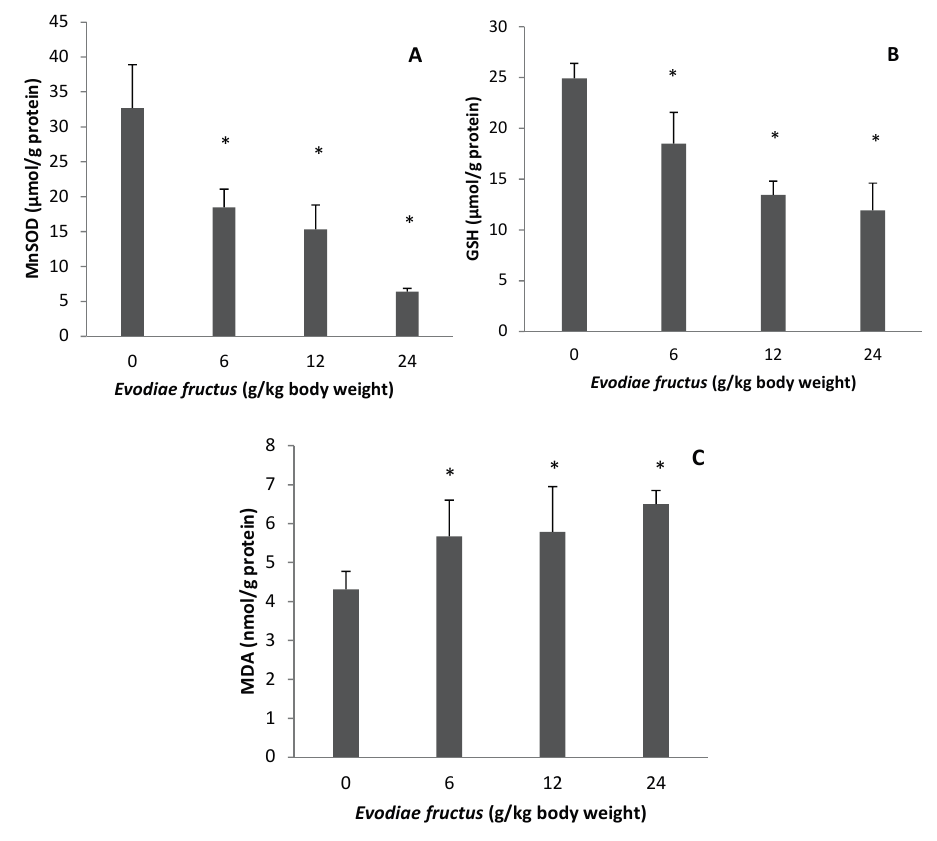
Figure 2. Effects of aqueous extract of EF on mitochondrial MnSOD ( A ), GSH ( B ) and MDA ( C ). Data were presented as mean ± SEM (n = 10). Compared with control group * p <